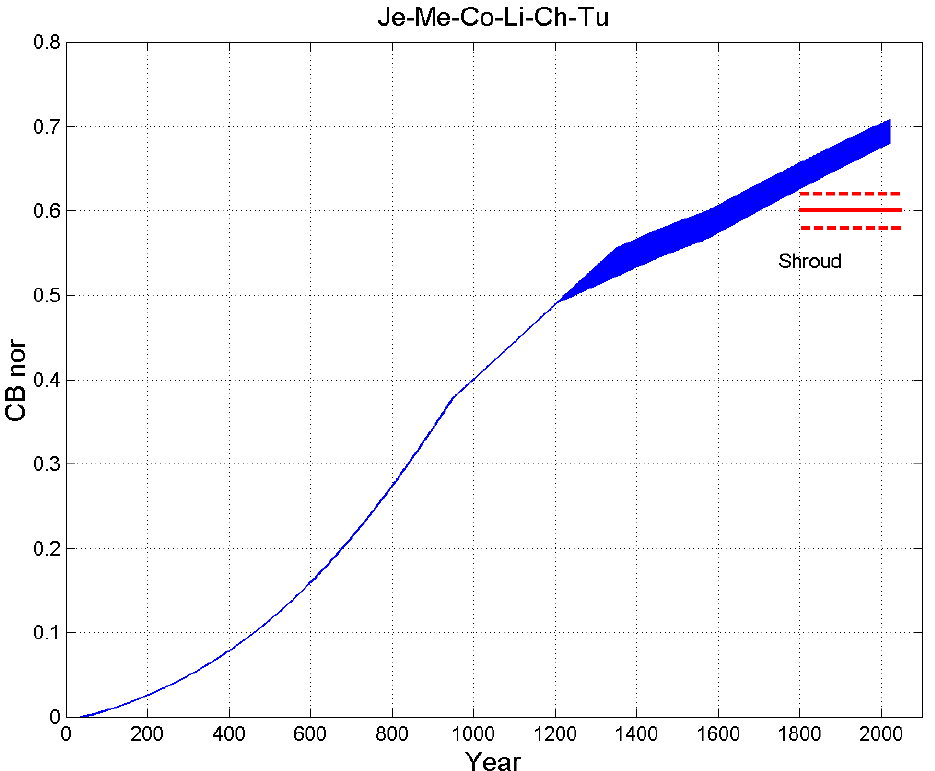
Figure 7. CB nor versus year in the Jerusalem–Memphis–Constantinople–Lirey–Chambéry–Turin path 3 (Tables 1 and 2; Figure 1) until the year 2021. Each curve assumes a different arrival year in Europe, t Eu , randomly generated from a uniform distribution in the interval 1204 ≤ t Eu ≤ 1354. The upper curve assumes t Eu = 1354, while for the lowest curve t Eu = 1204. In 2021, CB nor , min = 0.685, C nor , max = 0.713, and CB norm , ave = 0.699. The continuous red line indicates the average experimental CB nor = 0.60 measured for the Shroud [9]; the dashed red lines indicate ± 1 standard deviation bounds due to measurements uncertainty.